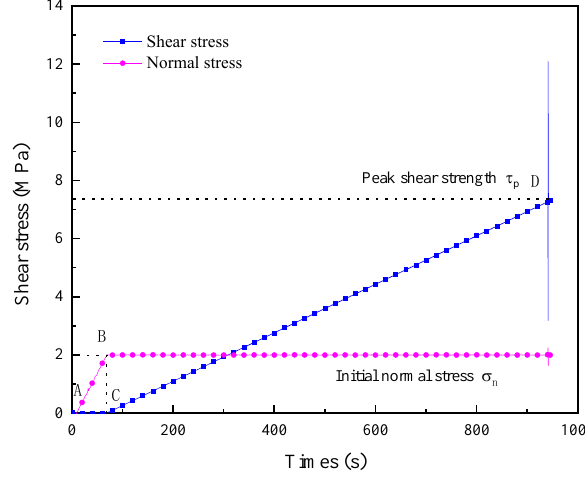
Figure 6. Schematic diagram of sample loading path.